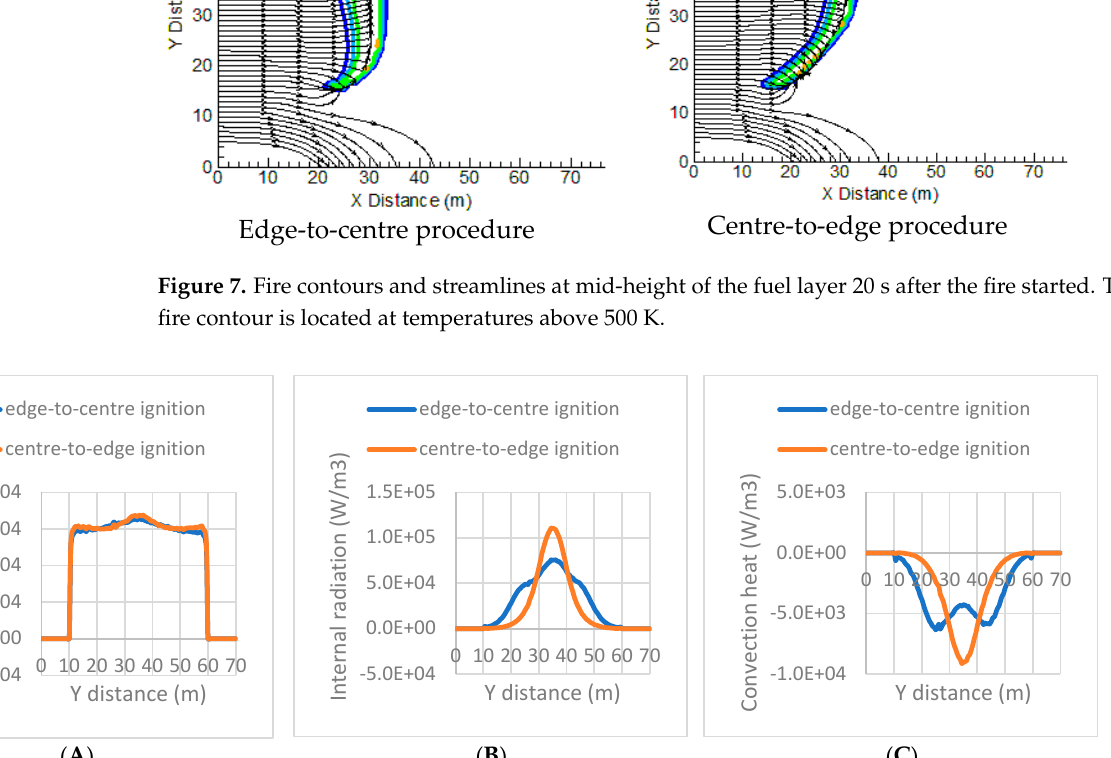
Figure 8. Heat fluxes as a function of distance in the plane x = 25 m, perpendicular to the direction of fire spread, 20 s after the start of the fire: ( A ) Heat flux due to flame radiation; ( B ) Heat flux due to ember radiation; ( C ) Heat flux due to convection.